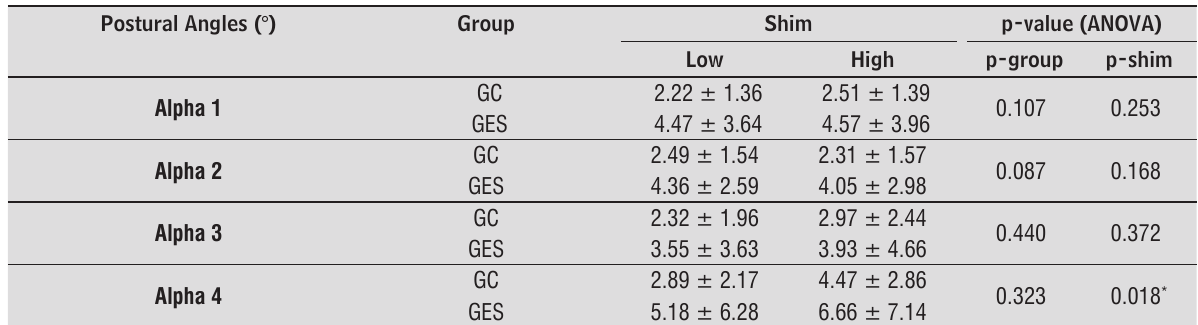
Table 5 - Analyses of postural angles with respect to the group and shim factors between the control and experimental "C" groups in the static condition with left